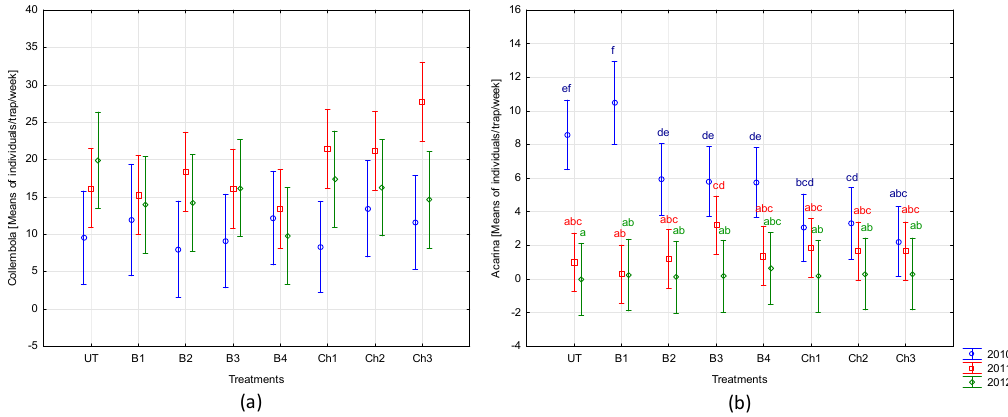
Figure 5. Number of trapped individuals of ( a ) Collembola and ( b ) Acarina in broad bean crop depending on the protection method used: Treatments are the same as in Table 1. Vertical bars denote 0.95 confidence intervals. Means followed by the same letters are not significantly different according to the LSD test ( p < 0.05), factors: year × protection method. Table 5. Results of the statistical analysis of the presence of Collembola and Acarina. SS —sum of